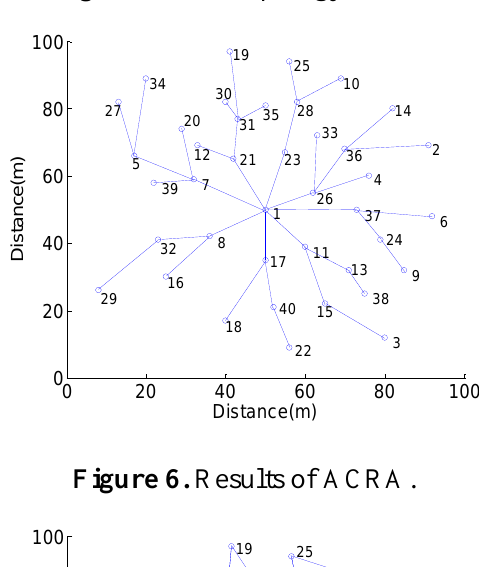
Figure 5. Tree topology model.